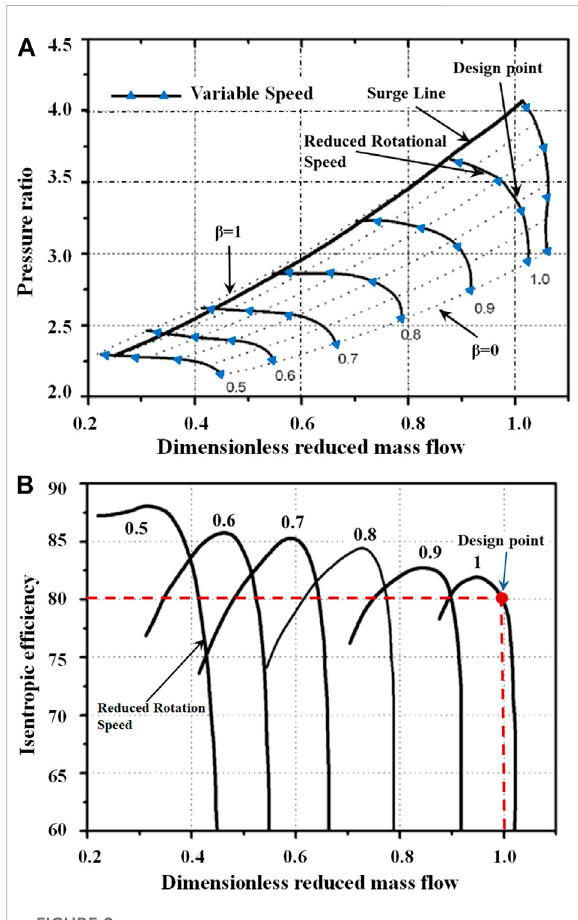
FIGURE 2 Compressor characteristic curve (A) Compressor pressure ratio curve; (B) Compressor ef fi ciency